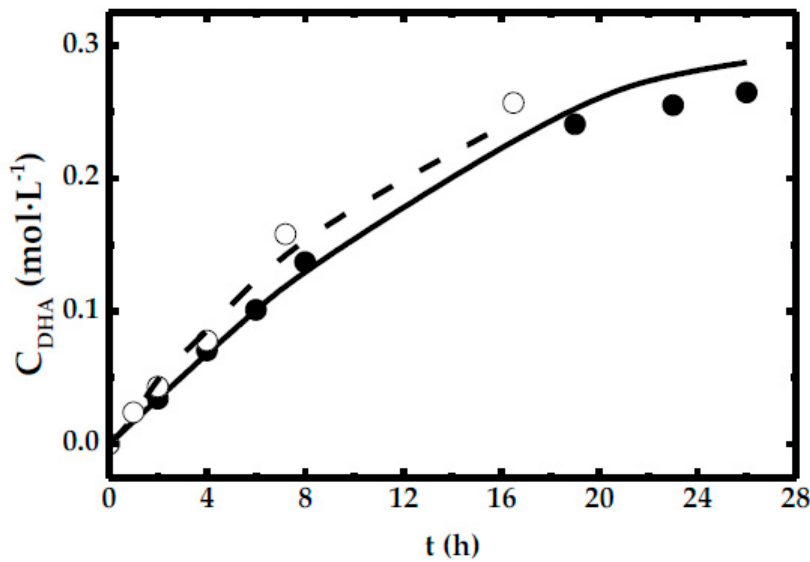
Figure 10. Variation of DHA concentration vs. time for runs 20 and 21, carried out in STBR, with stirring speeds of 360 rpm ( (cid:8) ) and 420 rpm ( ). Points are experimental results and lines plot the stirring speeds of 360 rpm ( ● ) and 420 rpm ( ○ ). Points are experimental results and lines plot the (cid:35) kinetic model given by Equation kinetic model given by Equation (7).